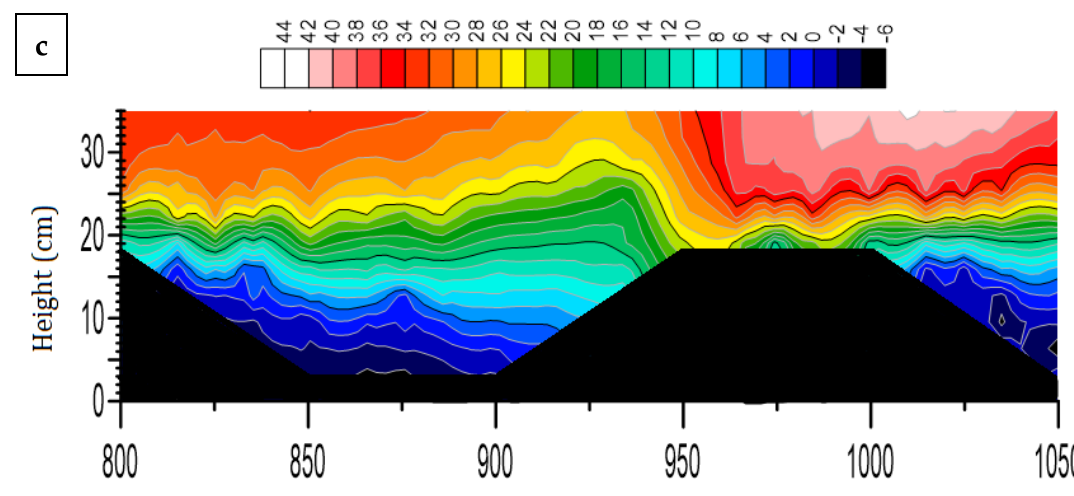
Figure 10. Velocity contour in the x-direction for: ( a ) series “ a ” test in the central axis of the channel, with an angle of 5° and aspect ratio of less than five, ( b ) series “ b ” test in the center axis of the flume, with an angle of 5° and aspect ratio of more than five, and ( c ) series “ c ” test in the center axis of the flume, with an angle of 20° and an aspect ratio of less than five.